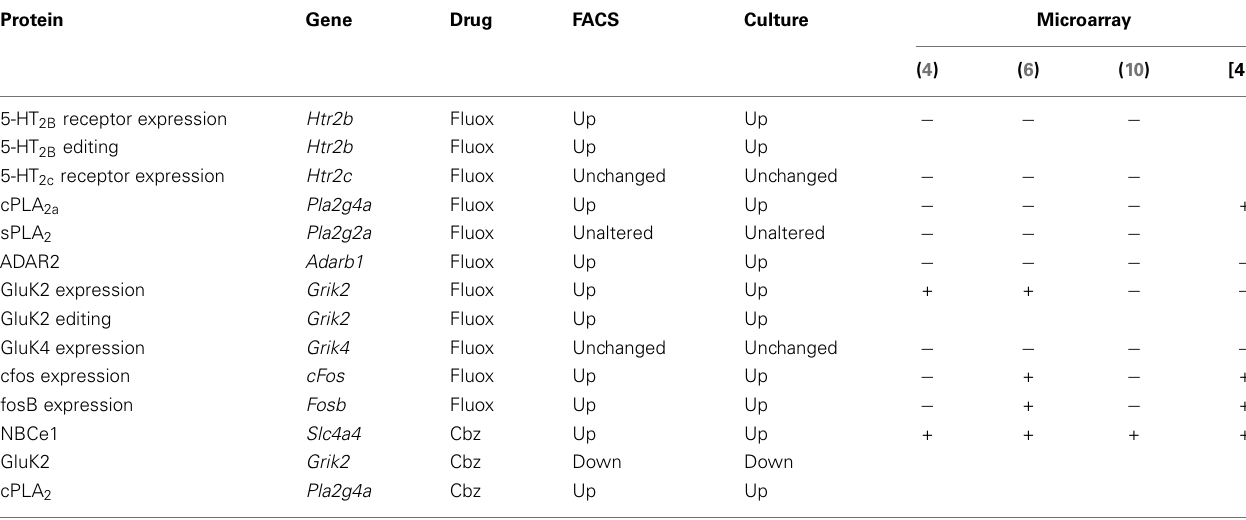
Table 2 | Drug effects on gene expression and editing in astrocytes are identical in freshly isolated cells from treated animals and primary cultures of astrocytes, but the expression is often not recognized by the microarray analyses, indicatest as + or − .